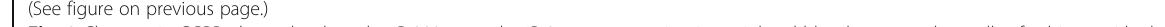
Table 3 Biochemical data of CM-MO patients before and after detoxification T0 T1 Statistical analysis All patients Responders Non-responders All patients Responders Non-responders TIME GROUP TIME n 28 23 5 28 23 5 – CGRP